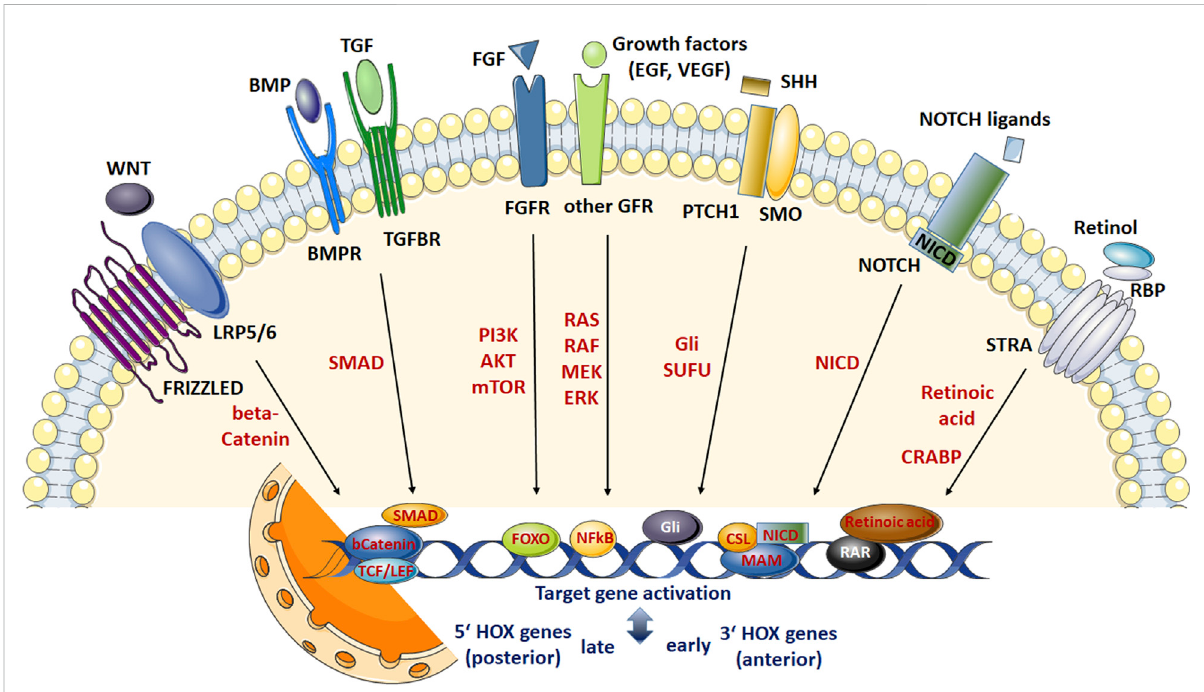
FIGURE 1 Schemesummarizingthemostrelevantsignalingnetworksregulatingstemcellfate.Developmentofadultstemcells(ASCs)aswellasstemcell maintenance,proliferation,differentiationandsurvivalrequirecomplexinteractionsbetweendiversemolecularsignalingpathwaysanddownstream transductionmolecules.ThesepathwaysincludeWNTsignaling,signalingbymulti-functionalgrowthfactorsthatbelongtothetransforminggrowth factor (TGF) beta superfamily, fi broblast growth factor (FGF) signaling, sonic hedgehog (SHH), NOTCH, and retinoic acid (RA) signaling pathways. WNT ligand binding to the receptor complex consisting of FRIZZLED and low-density lipoprotein receptor-related proteins 5/6 (LPR 5/6) results in intracellular β -catenin stabilization enabling nuclear translocation. Nuclear β -catenin then elicits gene expression changes (including HOX genes)throughtheT-cellfactor(TCF)/lymphoidenhancerfactor(LEF)familyoftranscriptionfactors.SignalingpathwaysinitiatedbyTGF β ligandsare transduced through cell surface receptor complexes resulting in (type I; BMPR, TGFR) receptor phosphorylation and serine-threonine phosphorylations of (effector) SMAD transcription factorsmeaning activation. Following nuclear translocation (in complexes formed with SMAD4) target gene transcriptions (including HOX genes) are activated. SMADs further can interactwith β -catenin and LEF/TCF transcriptional regulators enablingWNTsignaling in a TGF β -dependentmanner. FGF ligands, and FGF receptors(FGFR) -like other growth factor receptors including epidermal andvascularendothelialgrowthfactorreceptors-leadtoautophosphorylationofthe(intracellular)proteintyrosinekinasedomainsandactivationof various effectors suchasRAS/RAF/mitogen-activatedproteinkinase(MAPK) andphosphatidylinositol-4,5-bisphosphate3-kinase (PI3K)/AKT/mTOR and RAS/RAF/MAPKs fi nally mediating NF-kB (nuclear factor “ kappa-light-chain-enhancer ” of activated B-cells) or FOXO (Forkhead Box O)- dependent gene expressions (including HOX genes). Other signal transducers (Phospholipase C Gamma, PLC- γ ) and activators of transcription (STAT) pathways can also be activated, which intersect and synergize with other signaling pathways, e.g.,WNT, RA and TGF β signaling (not shown). SHHsignalsthrougha receptor complex that includes the G-protein-coupledreceptor smoothened(SMO) and the (twelve-pass)membrane protein patched 1 (PTCH1). In response to SHH ligand binding, SUFU (suppressor of fused) binding, and thus cytoplasmic sequestrations of GLI (glioma- associated oncogene familymembers)transcriptionfactors becomeinhibited,leadingto GLIstabilizationand nucleartranslocation resultinginSHH signal transduction, namely transcriptional activation of SHH target genes (includingHOX genes). NOTCH receptor activation results in NOTCH cleavage (through a cascade of proteolytic cleavages by ADAM metalloprotease and γ -secretase) releasing the intracellular domain of the receptor (NICD). NICD translocates to the nucleus, displaces corepressor complex, and recruits coactivators fi nally forming a ternary complex with the DNA binding protein CSL and the transcriptional coactivator Mastermind (MAM) to activate transcription of Notch target genes (including HOX